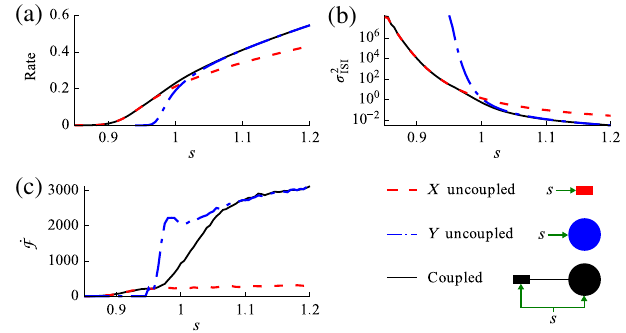
FIG. 3. The firing statistics of isolated units constitute asymp- totic curves for the dendrite-soma system. (a) Firing rate of coupled system (black line), X unit alone (i.e., dendrite alone, red line), and Y unit alone (i.e., soma alone, blue line) for different input strengths. (b) The interspike interval variance of the coupled system follows the minimum between isolated X and Y units. (c) Fisher information about the input strength. Parameters are described in